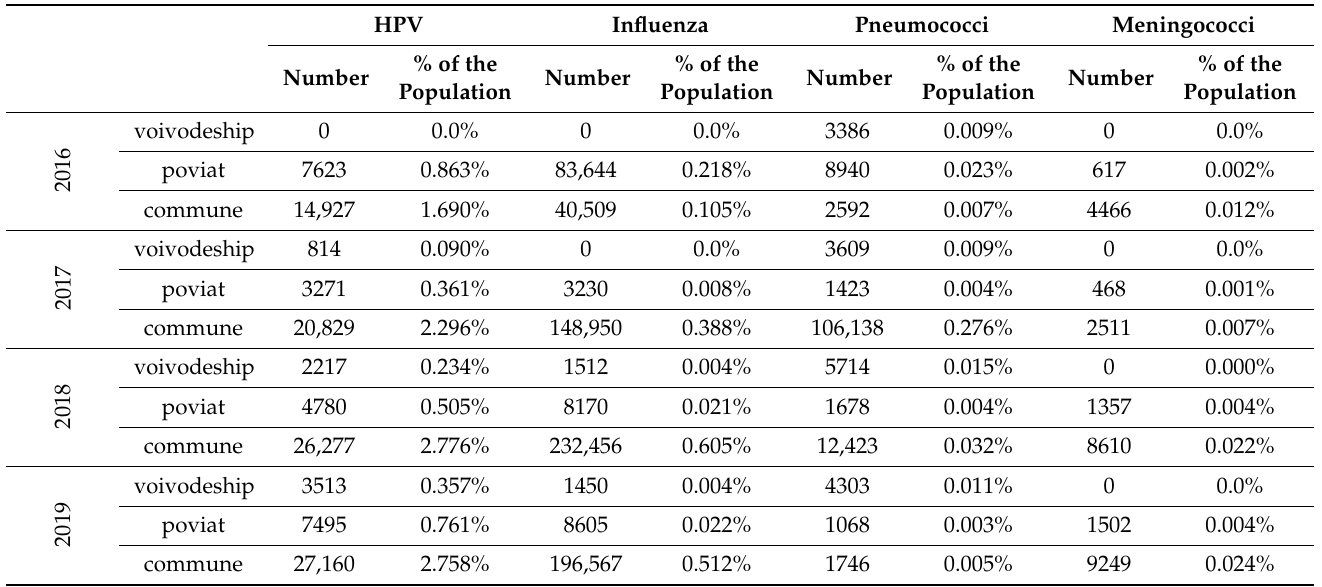
Table 4. People vaccinated under immunization programmes between 2016 and 2019.